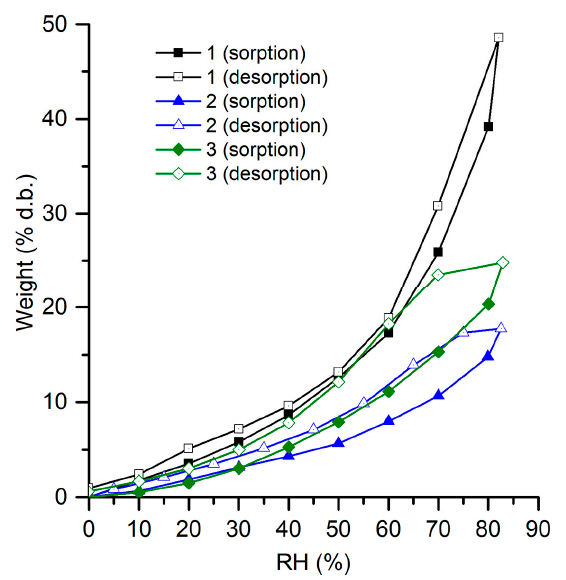
Figure 5. Sorption / desorption isotherms of the studied biomaterials (1—reference sample; 2—TAN Figure 5. Sorption/desorption isotherms of the studied biomaterials (1—reference sample; 2—TAN sample; 3—LIP sample). sample; 3—LIP sample).